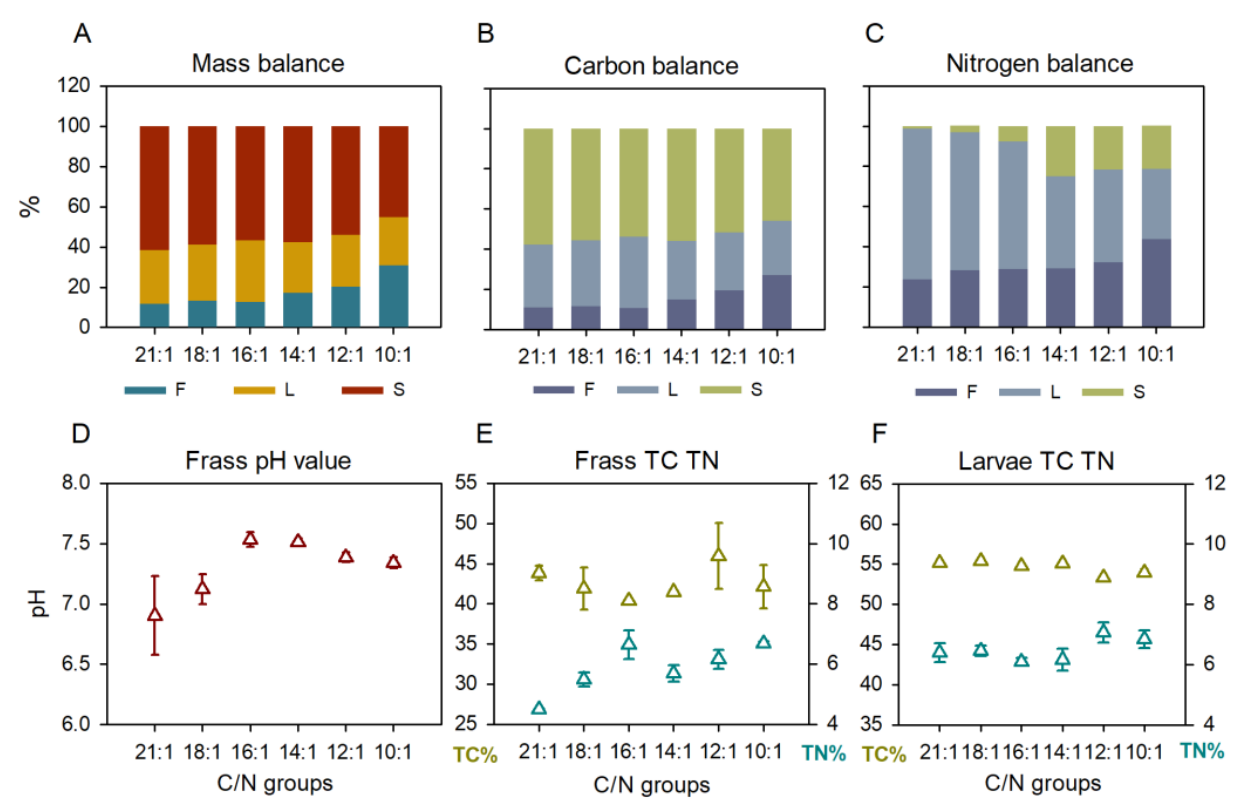
Figure 2. The mass, carbon and nitrogen balance and the pH, TC, and TN properties after 10 d of food waste treatment. F, frass; L, larvae; S, gaseous loss. Data points were presented as means ( A – C ) or mean ± SD ( D – F ), n = 3.